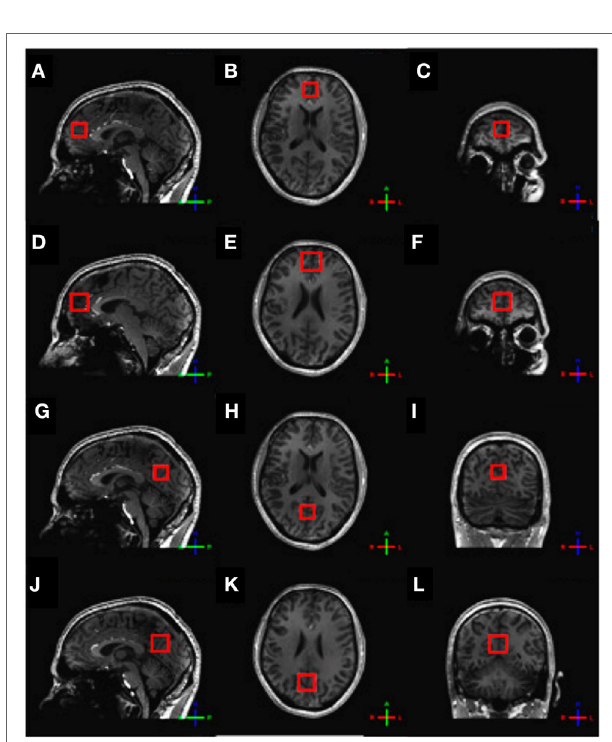
FigUre 2 | Voxel placement. (a) Frontal sLASER voxel, sagittal view; (B) frontal sLASER voxel, axial view; (c) frontal sLASER voxel, coronal view; (D) frontal MEGA-sLASER voxel, sagittal view; (e) frontal MEGA-sLASER voxel, axial view; (F) frontal MEGA-sLASER voxel, coronal view; (g) occipital sLASER voxel, sagittal view; (h) occipital sLASER voxel, axial view; (i) occipital sLASER voxel, coronal view; (J) occipital MEGA-sLASER voxel, sagittal view; (K) occipital MEGA-sLASER voxel, axial view; (l) occipital MEGA-sLASER voxel, coronal view [from Ref. (22)].